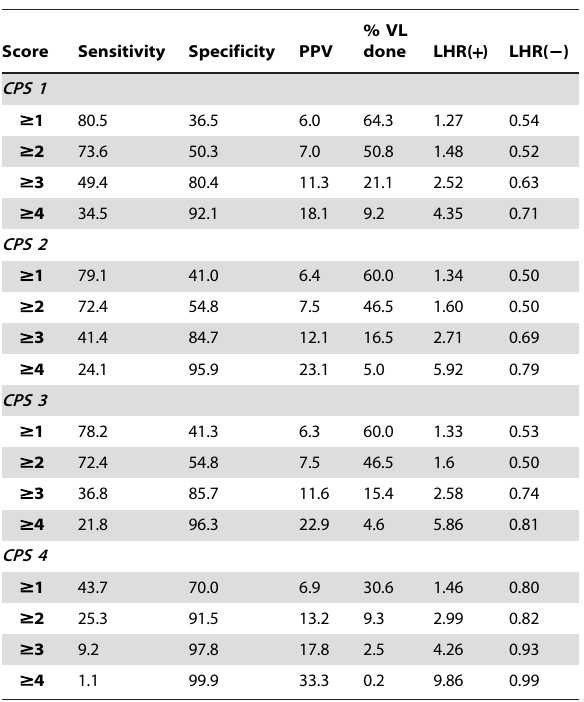
Table 3. Diagnostic performance at different cut-offs of the clinical prediction scores to identify virological failure using an independent